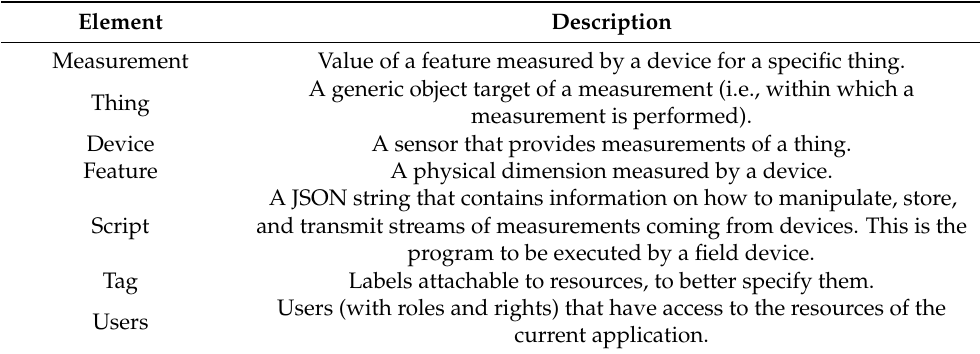
Table 2. Outlook of the main Measurify